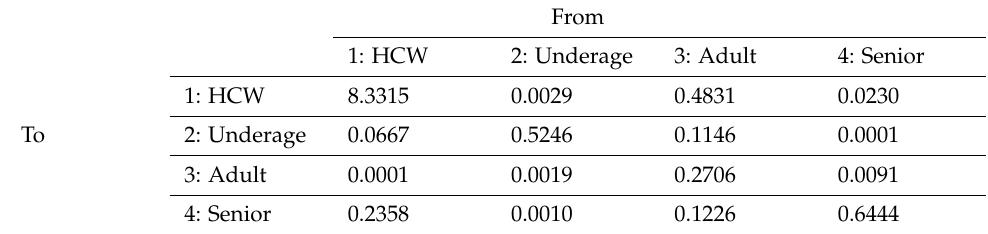
Figure 3. Estimated transmission rates. Purple, blue, green, and yellow represent the HCW, underage, adult, and senior groups, respectively. Table 1. The estimated transmission rates ( β XY